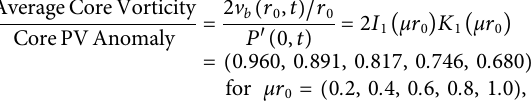
Figure 1. The solutions of the linear primitive equation model (Eq. 7) are obtained numerically using a second-order, centered fi nite differencing scheme radially, a fourth-order Runge-Kutta scheme temporally, an outer radial boundary set at r = 5000 km, a 100 m radial resolution, and a 1 s temporal resolution. Select